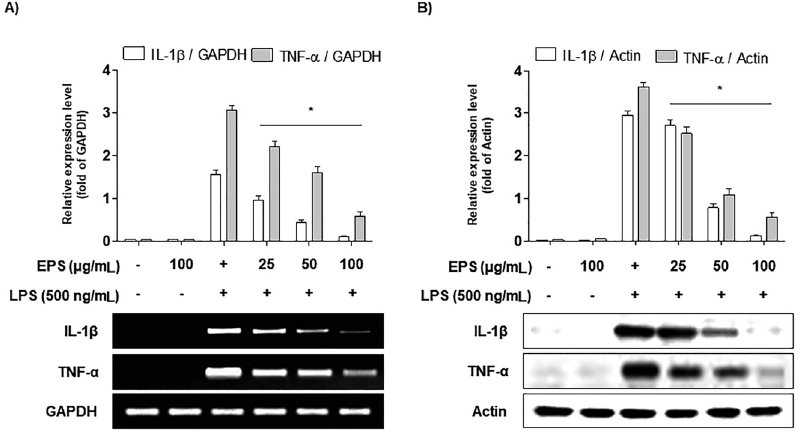
Figure 6: Effect of EPS on lipopolysaccharide (LPS)-stimulated tumor necrosis factor (TNF)- α and interleukin (IL)-1 β expression in RAW 264.7 cells. (A)RAW264.7macrophagecellswerepretreatedwithEPS(25,50,and100µg/mL)1hpriortoincubationwithLPS(500ng/mL)for24h.(A)TotalRNA waspreparedforreversetranscriptasePCR(RT-PCR)analysisofIL-1 β andTNF- α